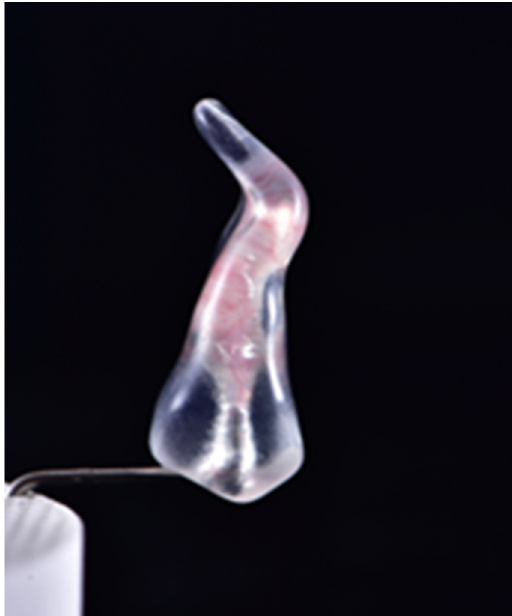
Figure 1. The selected double ‐ curved tooth model.